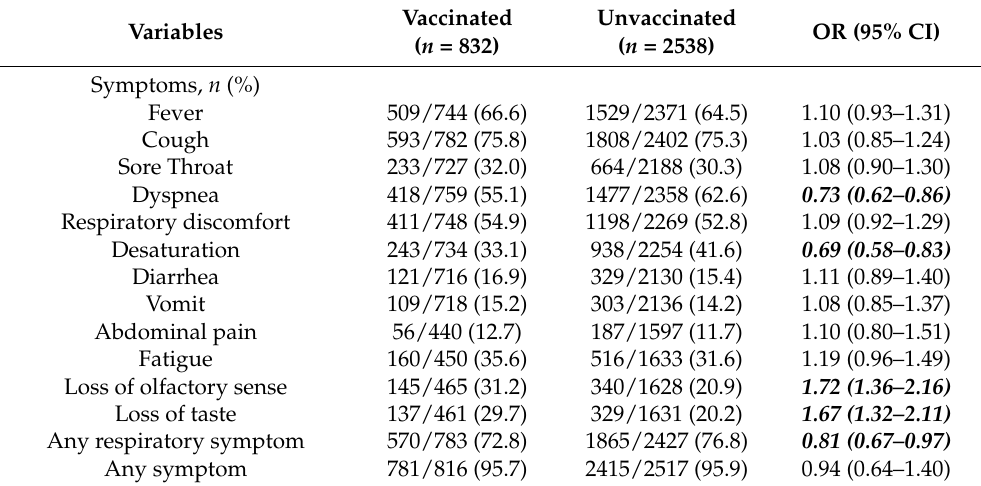
Table 2. Characteristics of COVID-19 symptoms according to vaccination